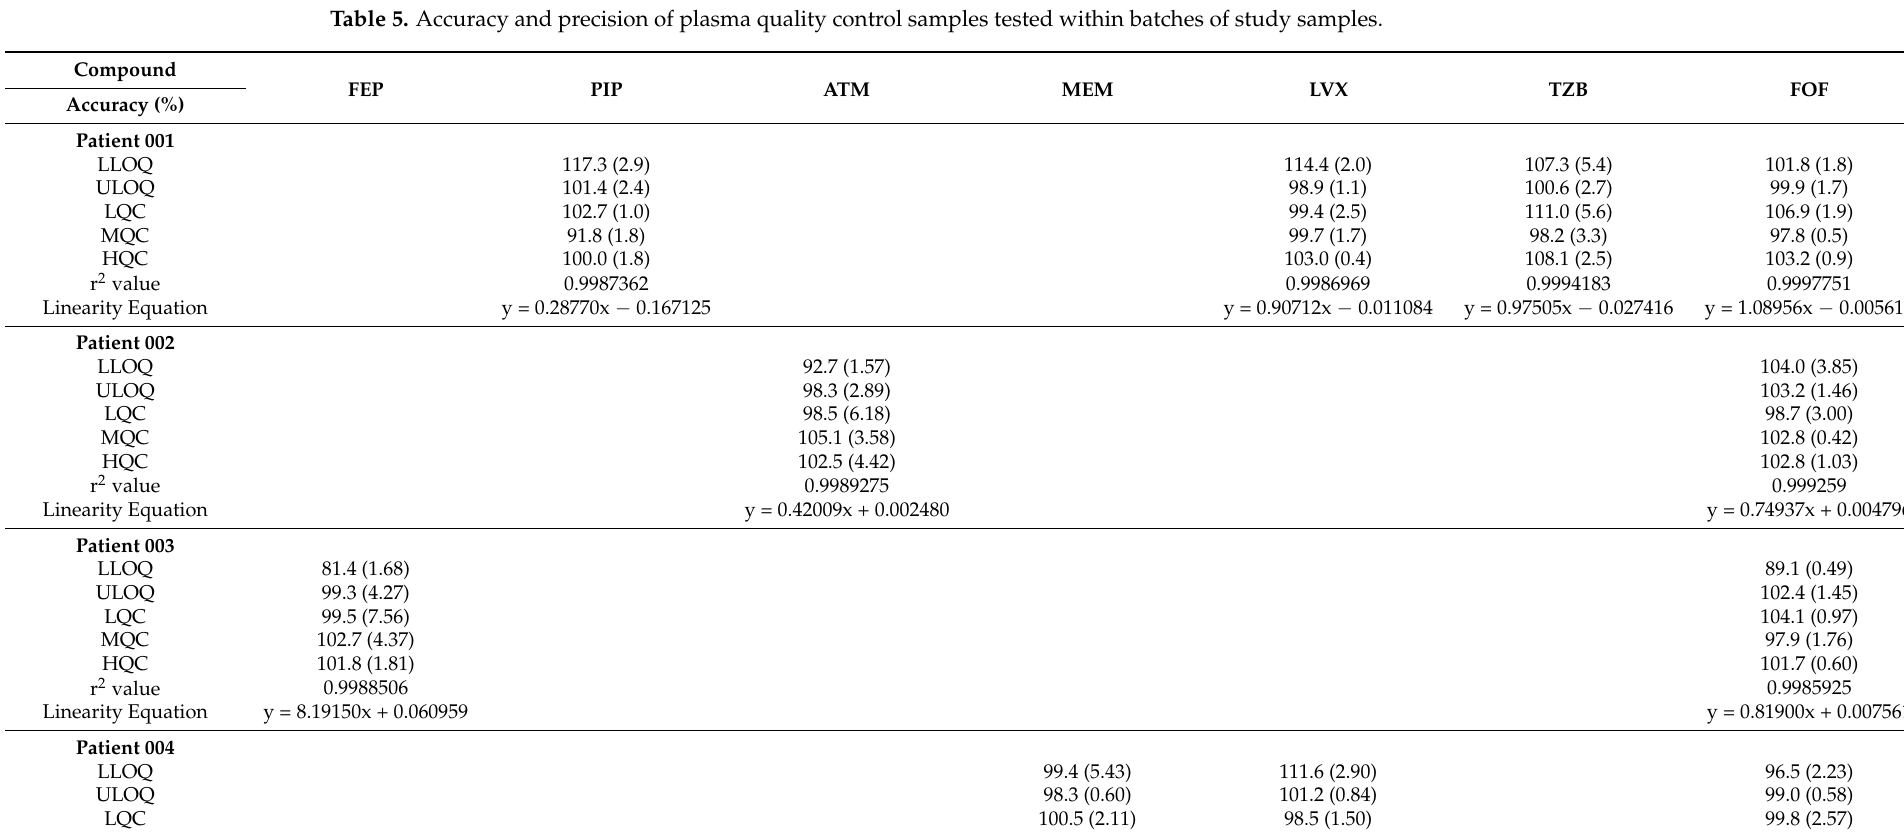
Table 5. Accuracy and precision of plasma quality control samples tested within batches of study